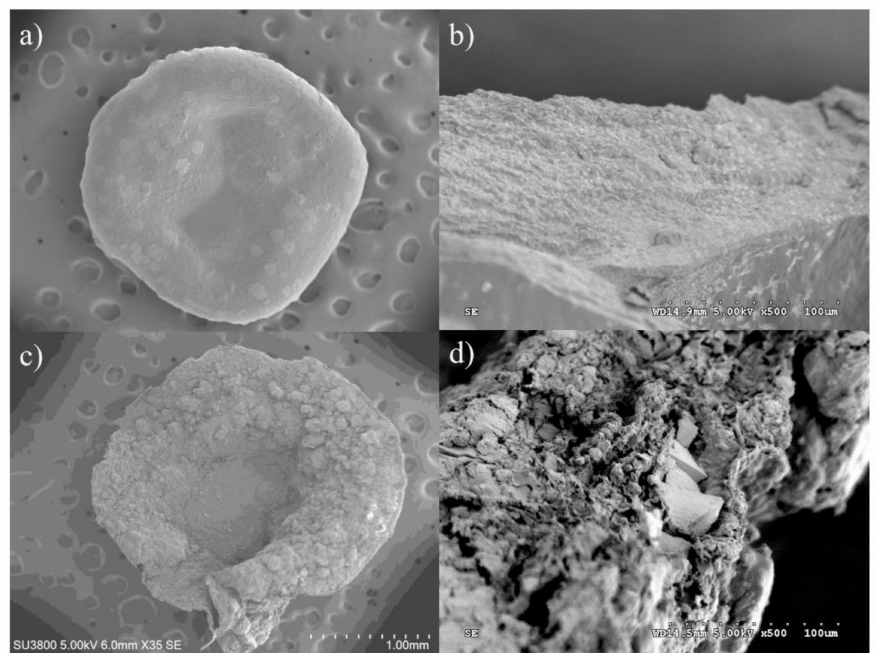
Figure 1. SEM images of hydrogel beads: ( a ) surface of sample from experimental design No. 4; ( b ) cross-section of sample from experimental design No. 4; ( c ) surface of sample from experimental design No. 16; and ( d ) cross-section of sample from experimental design No.